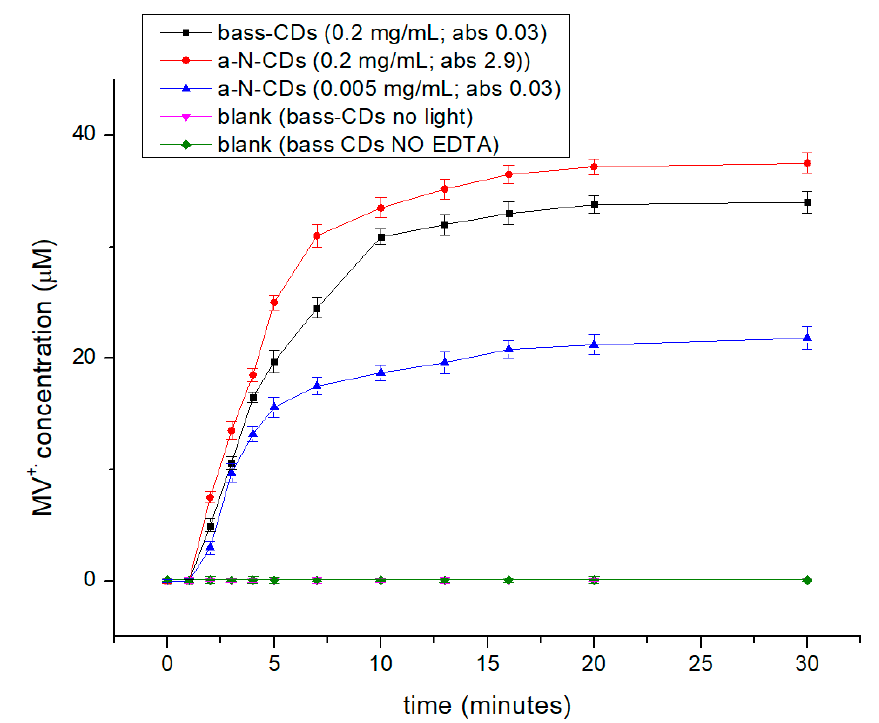
Figure 7. Reaction kinetics of the formation of methyl viologen radical (MV + ) using bass-CDs (black datapoints) and a-N-CDs (red and blue datapoints). Blank tests in absence of light (pink datapoints) and of EDTA (green datapoints). Table 3. Initial photoreduction rate (v 0 ), Quantum Yield (QY), mass absorption coefficient ( ε ), average lifetime ( τ ), and MV 2+ conversion of the synthesized CDs.